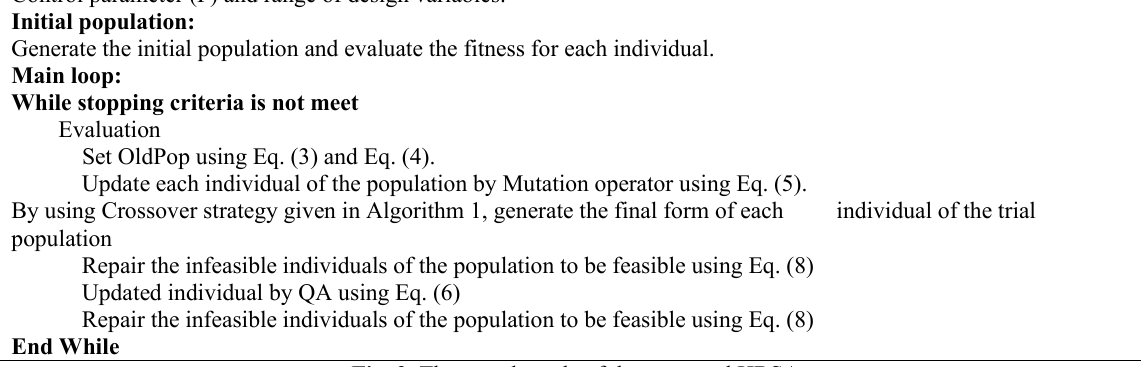
Fig. 2. The pseudo code of the proposed HBSA